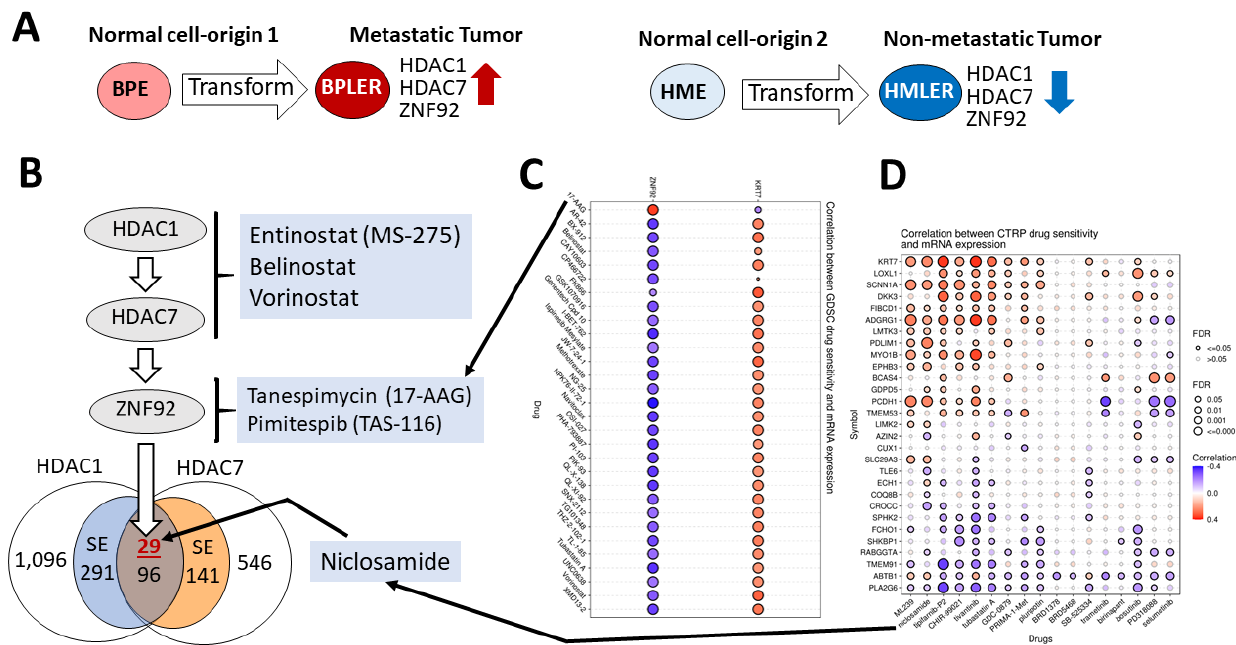
Figure 1. Identification of metastatic TNBC cell-of-origin targets and drugs. ( A ) The estrogen receptor negative normal breast cells cultures, BPE and HME, were generated from the same donor [2]. Transformation of BPE and HME with the same genes gave rise to metastatic BPLER and non-metastatic HMLER tumor cell lines with a TNBC phenotype [2]. The metastatic TNBC BPLER cells are associated with higher expression of HDAC1, HDAC7, and ZNF92 compared to non-metastatic TNBC HMLER cells [25,27]. ( B ) HDAC1 upregulates HDAC7, which in turn upregulates 29 super- enhancer (SE) associated genes with ZNF92 binding sites [27]. This HDAC1-HDAC7-ZNF92 axis can be targeted by HDAC inhibitors (Entinostat, Belinostat, and Vorinostat). ( C ) ZNF92 expression correlates only with 17-AAG sensitivity (arrow) among 265 small molecules in the Genomics of Drug Sensitivity in Cancer (GDSC) dataset, with IC50 in 860 cell lines and their corresponding mRNA gene expression (red circle, top left). All the other drugs negatively correlate with ZNF92 (blue circles). GSCA only draws plots for the top 30 ranked drugs; blue-filled circles represent negative correlation, red-filled circles represent positive correlation, the color intensity reflects higher correlation, the circle size is positively correlated with the false discovery rate (FDR) significance, and the black outline border indicates FDR ≤ 0.05. See supplemental data for details. ( D ) The correlation of the 29 gene ZNF92 signature with the IC50 of 481 small molecules in 1001 cell lines and corresponding mRNA gene expression from Genomics of Therapeutics Response Portal (CTRP). The mRNA expression data and drug sensitivity data were merged. Pearson correlation analysis was performed to get the correlation between gene mRNA expression and drug IC50. p -value was adjusted by FDR. Among the top ranked drugs shown, Niclosamide was ranked #2 (arrow). The blue-filled circles represent a negative correlation, red-filled circles represent a positive correlation, the color intensity reflects a higher correlation, the circle size is positively correlated with the false discovery rate (FDR) significance, and the black outline border indicates FDR ≤ 0.05. See supplemental data for details.